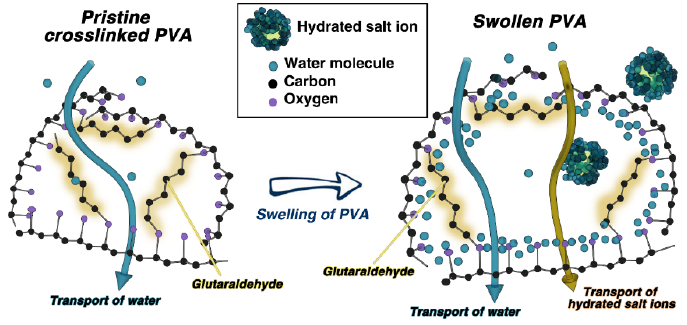
Figure 5. Schematic diagram of salt passage through the swollen PVA membrane (not to scale).